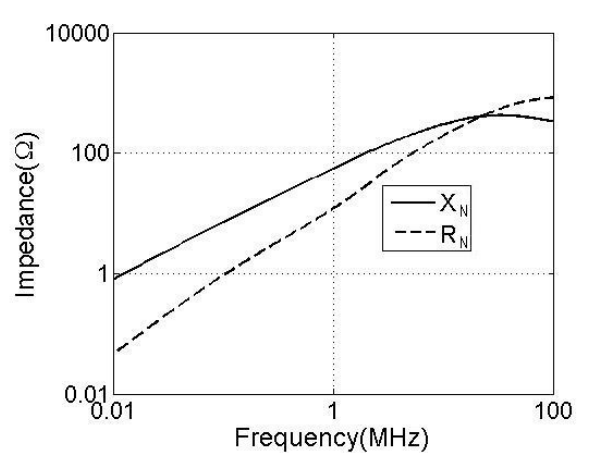
Figure 15: Measured of R